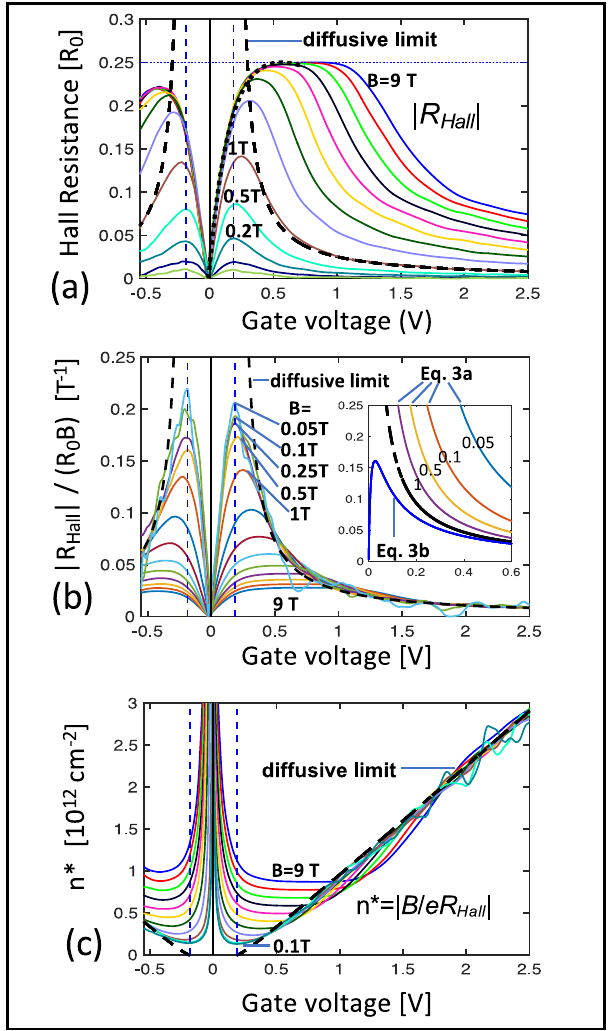
Fig. 7 | Absence of an edge state Hall voltage. a Hall resistance R Hall =| R 26,15 | (in unitsof R 0 )versus V G for0.02T ≤ B ≤ 9TshowsananomalousquantumHallplateau at ≈ 0.25 R 0 for B >3T, consistent with a quantum Hall plateau from the dispersing branch N =0 subband that is shorted by the edge state (see Eqs. 3b, 4). The black dashedlinesisthediffusive bulklimitfor B =1T. b Thenormalized Hallresistance| R R B | converges to the diffusive bulk limit for B <0.5T and V G >0.4V. For Hall / 0 V G <0.4V and B <0.1T it becomes independent of B and saturates at ≈ 0.2T − 1 and then decreases to 0 independent of B as V G decreases to 0. This behavior is pre- dicted in Eq. 3b (inset); Eq. 3a (inset) does not correspond at all, showing that the edgestatedoesnotgenerateaHallvoltage. c Effectivechargedensity n *=| B / eR Hall |. For small B and/or large V G , n* converges to the diffusive limit (thick black dashed line)whichiscorrectedforthequantumcapacitance.Asigni fi cantgap Δ V G =0.17V isobservedwhichindicatesabandgapwhichhowevercannotbequanti fi edbythis